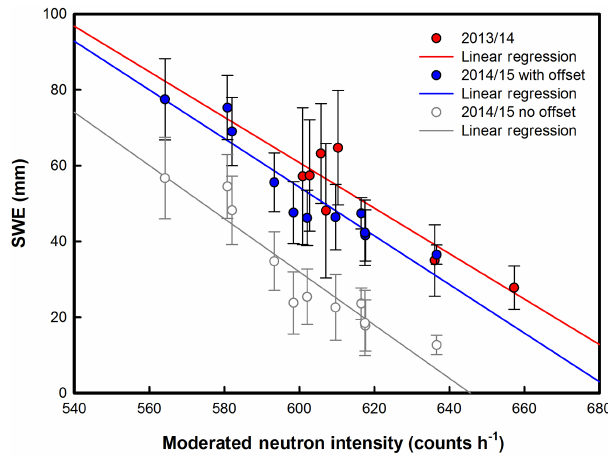
Figure 4. Linear regression of 2013/2014 measured SWE and corre- sponding moderated neutron intensity. Error bars represent standard deviation of